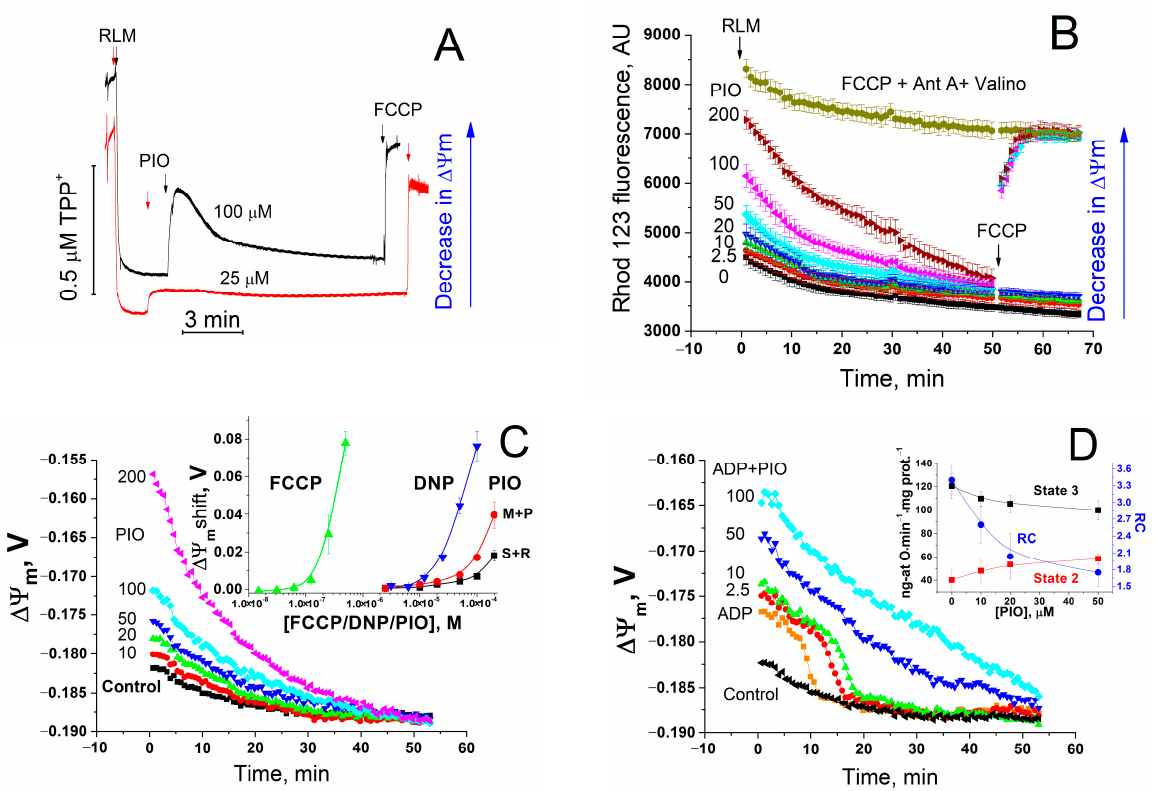
Figure 1. Effect of PIO on ∆Ψ m and the coupling of mitochondria. ( A , B ) Assessment of the effect of PIO on ∆Ψ m using TPP + ( A ) and rhodamine 123 (Rhod 123, ( B )). ( C , D ) Effect of PIO on ∆Ψ m in mitochondria in the resting state ( C ) and during the ADP phosphorylation ( D ). ( A ) Rat liver mitochondria (RLM) (1 mg prot./mL) were placed in a standard incubation medium supplemented with 5 mM K + -succinate, 1 mM EGTA, rotenone (2 µg/mL), and 1 µM TPP + . Arrows show the addition of 25 or 100 µM PIO and 500 nM FCCP. ( B – D ) A mitochondrial suspension (0.75 mg/mL) supplemented with respiratory substrates, 1 mM EGTA, and 330 nM rhodamine 123 was placed in wells with 1% dimethyl sulfoxide (DMSO) (vehicle control) or PIO at indicated concentrations (µM) ( B – D ), 500 nM FCCP, antimycin A (2.5 µg/ml), and valinomycin